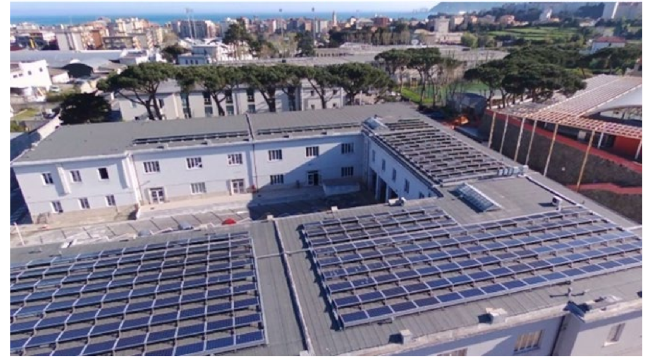
Figure 3. PV power plants of the SPM